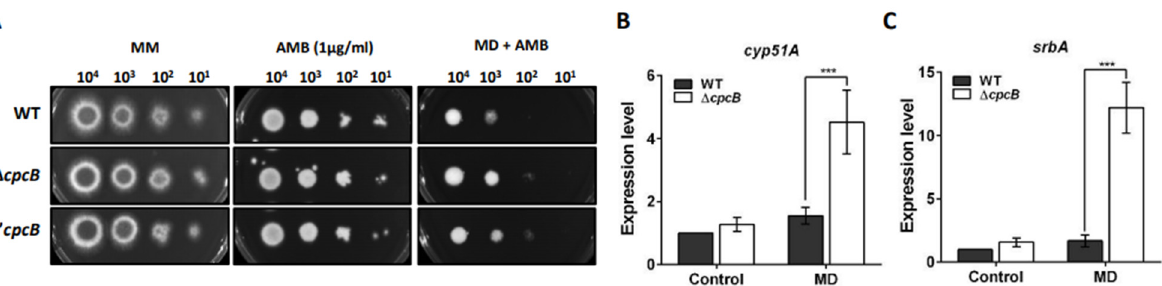
Figure 7. Resistance to AMB and expression pattern of cyp51A and srbA genes under oxidative stress conditions. ( A ) Sensitivity of the WT, Δ AfcpcB , and C’ AfcpcB strains to 1 μ g/mL of AMB in the presence and absence of 10 μ M MD. Conidia with 10-fold serial dilutions were spotted onto media and the plates were then cultured at 37°C for 2–3 days. Expression pattern of genes associated with ergosterol biosynthesis, ( B ) cyp51A , and ( C ) srbA ( n = 4). Mycelia were cultured in liquid broth, transferred onto GMM (Control) and GMM containing 10 μ M MD (MD), and incubated for 6 h. The RT-qPCR expression ratios were normalized using the 18S rRNA gene. Statistical analysis was performed using Student’s t -test. *** p < 0.001. AMB, amphotericin B; MD, menadione.